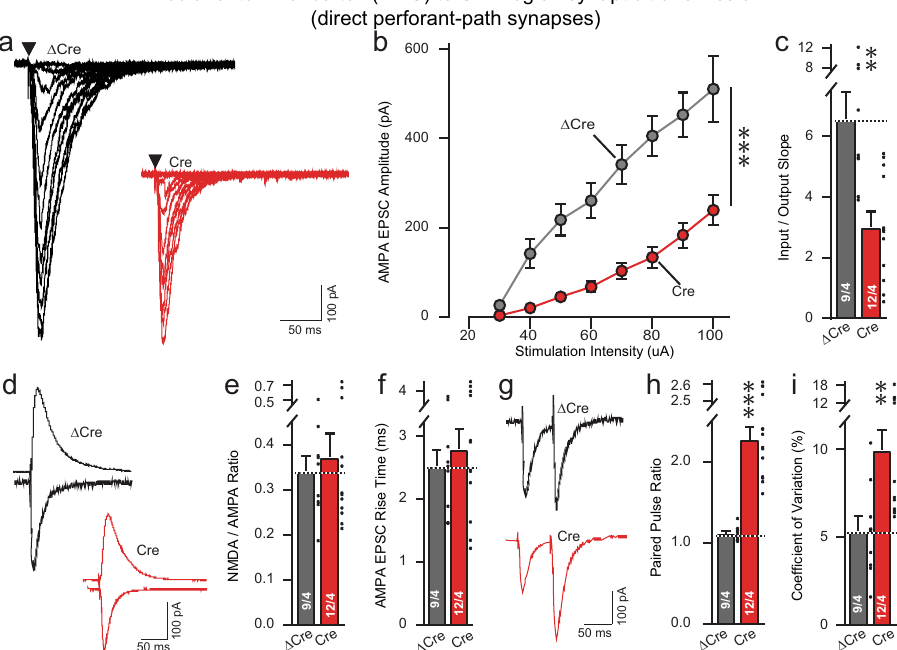
Fig. 10 Presynaptic Tenm3 and Tenm4 deletions in the MEC severely impair MEC → CA1 synaptic transmission. Data are from patch-clamp whole-cell recordings in acute hippocampal slices from Tenm3 and Tenm4 DcKO mice at P19-22. The MEC neurons of mice were infected unilaterally with AAVs encoding EGFP-tagged Δ Cre (control) or Cre at P0. Presynaptic deletion in MEC neurons severely decreases perforant-path synaptic strength ( a representative traces showing perforant-path EPSC at increasing stimulus; b input – output curves were used to control for differences in stimulus strength; c summary graph of the slopes of the input-output curves). The Tenm3/4 double deletion in CA1 neurons has no effect on the AMPAR/NMDAR ratio and AMPA EPSC rise time in perforant-path inputs compared to Δ Cre controls ( d , representative traces of AMPAR/NMDAR EPSC; e , summary graph of the AMPAR/NMDAR EPSC ratio; f , summary graph of the AMPA EPSC rise time). Double deletion of Tenm3 and Tenm4 signi fi cantly increases the paired-pulse ratios of perforant-path EPSC ( g , representative traces; h , summary graph of the paired-pulse ratios), or the coef fi cient of variation ( i , summary graph of the coef fi cient of variation). Data are means ± SEM; numbers of sections/mice are indicated in the bars. Statistical signi fi cance was assessed using two-sided Student ’ s t-test (* p < 0.05; ** p < 0.01; *** p < 0.001). For additional experiments, see Supplementary Fig.